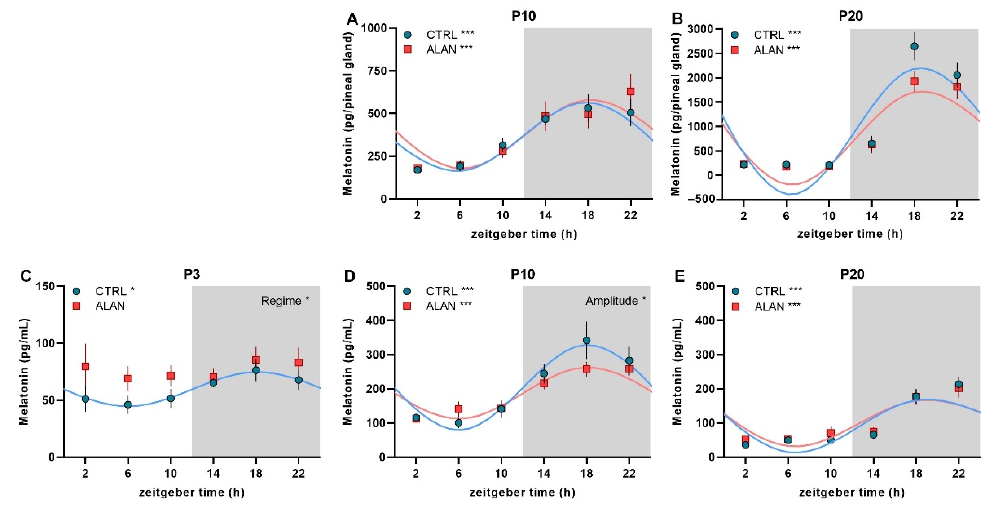
Figure 1. Effects of gestational dim ALAN (~2 lx) on the early development of daily melatonin rhythms. Pineal melatonin rhythms on postnatal day P10 ( A ) and P20 ( B ) and plasma melatonin rhythms on P3 ( C ), P10 ( D ), and P20 ( E ) in rat pups that were delivered by mothers exposed to either the control light–dark cycle (CTRL) or ALAN during pregnancy. Symbols represent the mean ± SEM, n = 3–6 rats per time point and group. The significant 24-hour rhythms are fitted with a cosine curve for CTRL (blue solid line) and ALAN (red solid line) groups at *** p < 0.001 and * p < 0.05. Non-rhythmic data are not fitted with the cosine curve. Significant group differences in the rhythm amplitude and the main effects of the Regime from two-way ANOVA are indicated at * p < 0.05. Zeitgeber time 0 = light on. Grey area represents the dark phase. Note different scales in graphs.